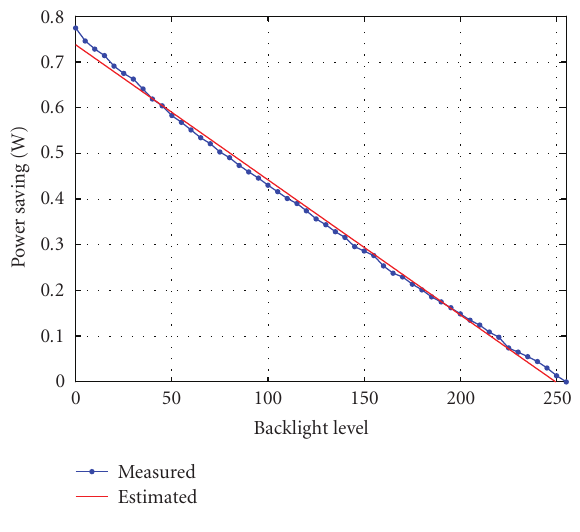
Figure 7: MSE with di ff erent